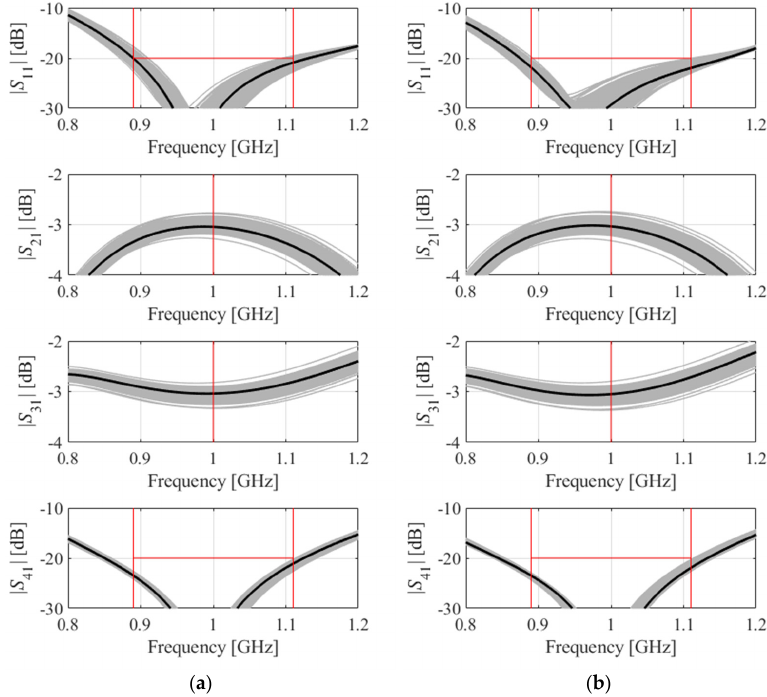
Figure 5. EM-driven Monte Carlo simulation of Circuit I (Figure 3a) at ( a ) the nominal design, and ( b ) the final design obtained using the proposed algorithm. MC carried out using 500 random samples. EM simulation data shown as gray curves. Black plots show the circuit responses at the nominal ( a ) and the optimized design ( b ).